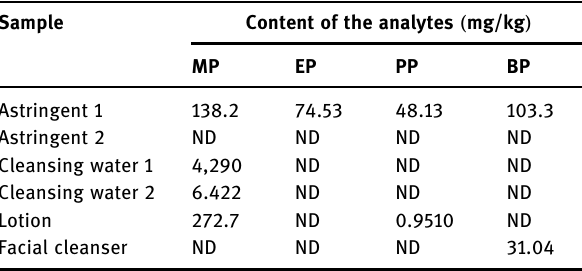
Table 4: Concentrations of four parabens in real samples